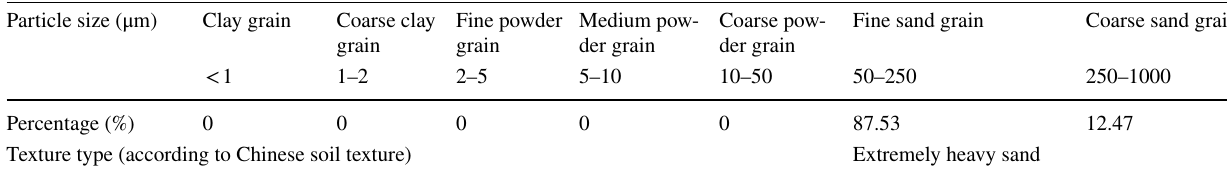
Table 1 Texture of Yellow River sediment Particle size (μm)